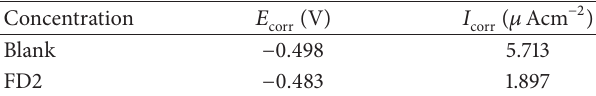
Figure 8: Polarization curves of T91 steel in 3% NaCl solution without and with 0.1 𝜇 M FD2. Table 2: Electrochemical parameters for T91 steel in 3% NaCl